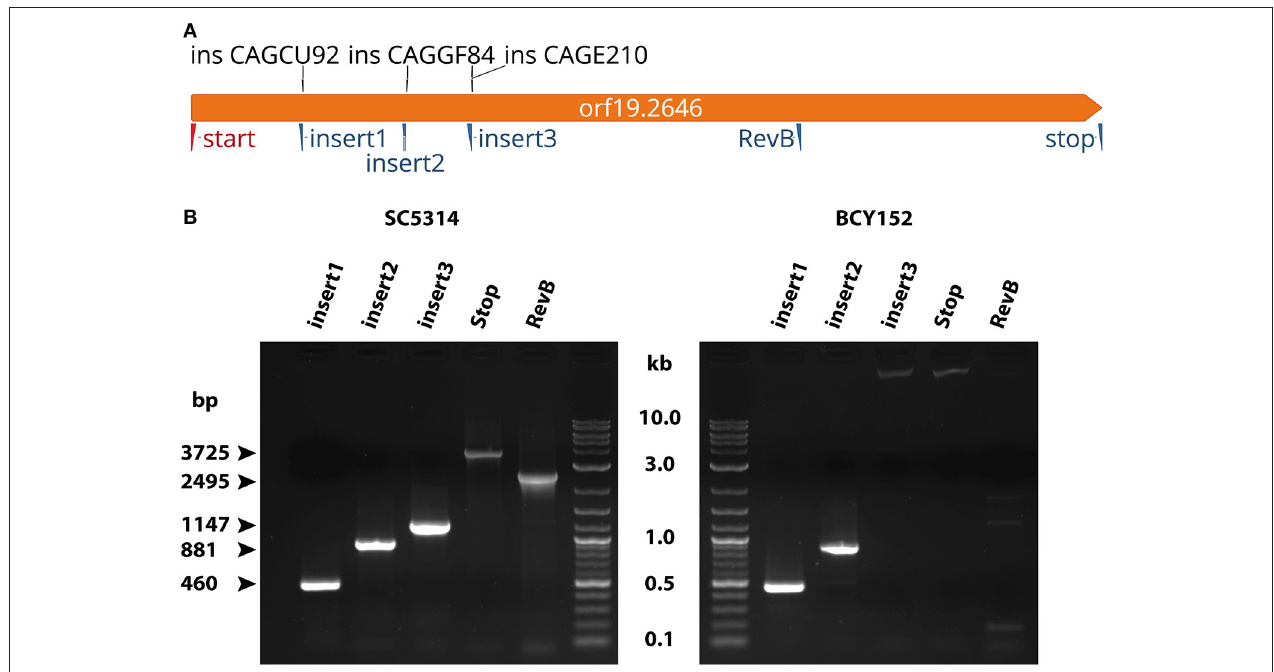
FIGURE 1 | Analysis of the Tn7-UAU cassette location in orf19.2646 . (A) Map of orf19.2646 gene with the three different possible insertions (ins CAGCU92, ins CAGGF84, and ins CAGE210) of the Tn7-UAU cassette as sequenced by TIGR. Triangles represent position of the forward (red) and reverse (blue) primers used to detect the insertion of the Tn7-UAU cassette. (B) PCR amplification on SC5314 DNA (left panel) and orf192646 Tn7 mutant (BCY152) DNA (right panel). Each PCR was performed using the forward primer “start” and reverse primers as indicated.